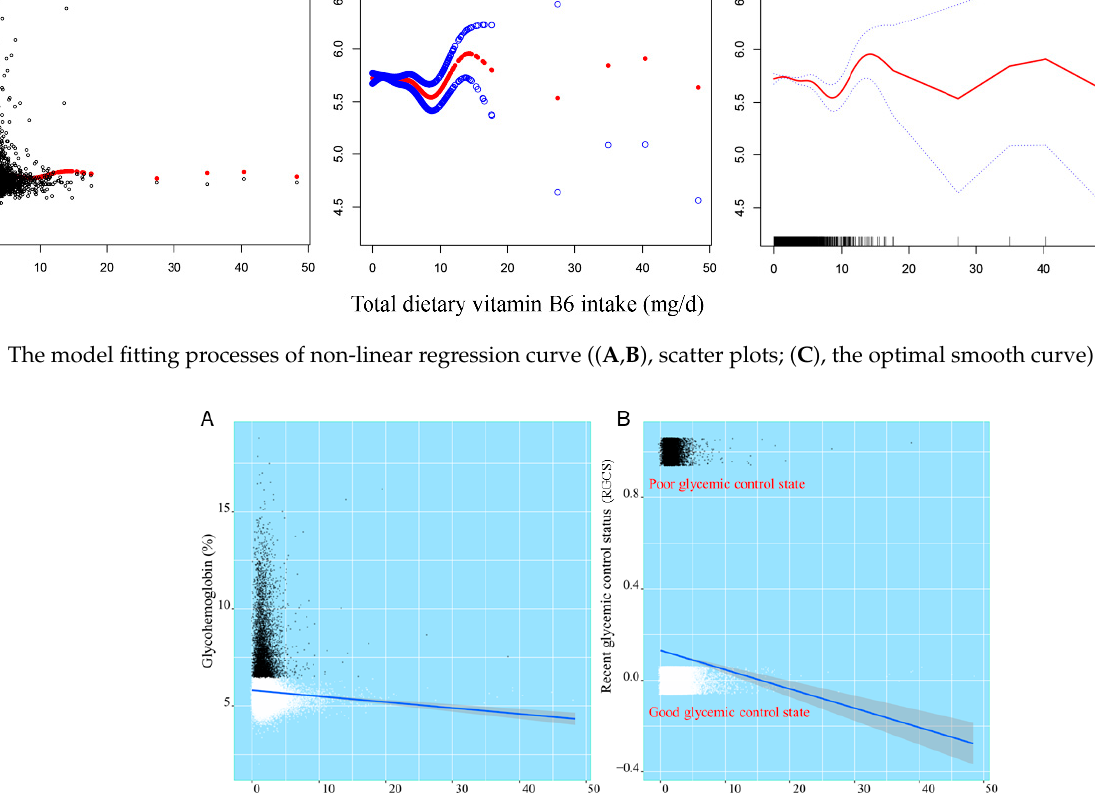
Figure 4. The linear discriminant analysis of daily total dietary vitamin B6 intake, glycohemoglobin ( A ), and RGCS ( B ).